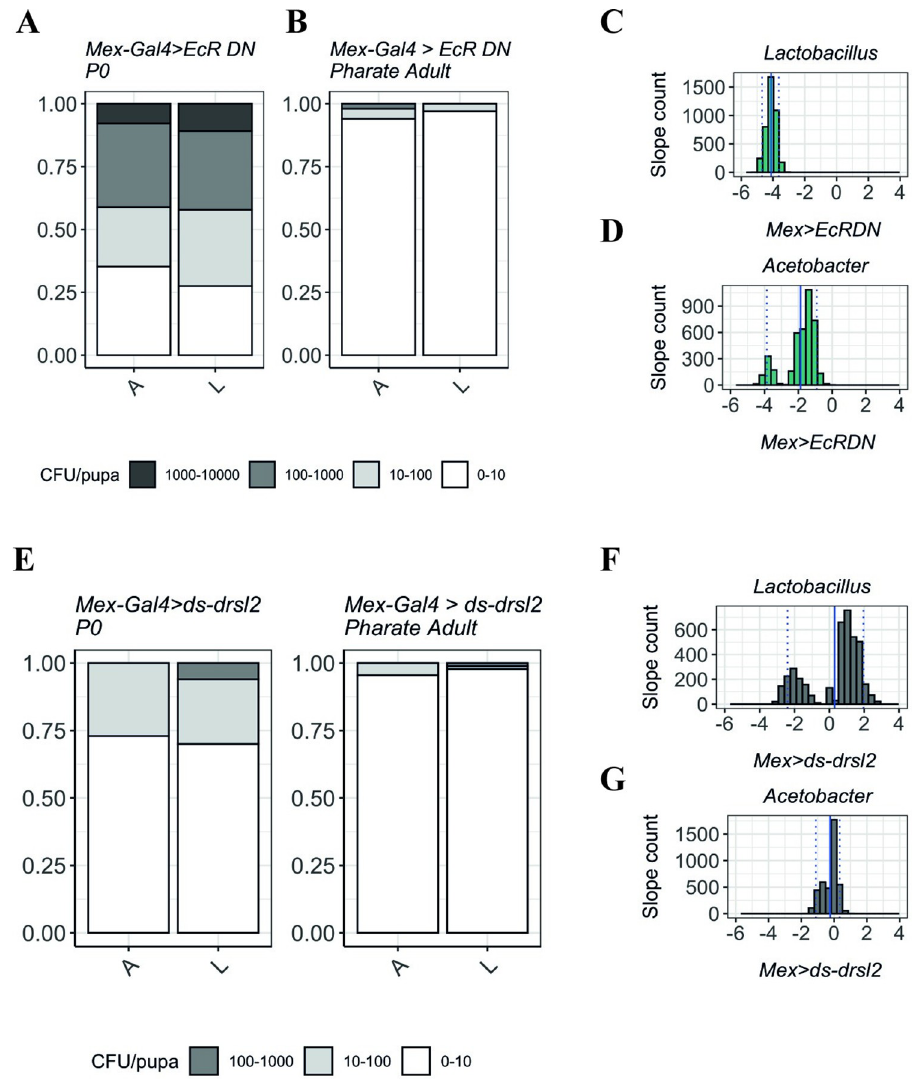
Fig 8. The role of local gut response in controlling the loads of Lactobacillus (L) and Acetobacter (A) in P0 pupae and pharate adults. (A-B) When ecdysone signalling is decreased in the enterocytes, the number of bacteria persisting metamorphosis does not increase. Y-axis represents the proportion of individuals in each bacterial count category. (C-D) Decrease in bacteria numbers in Mex > EcRDN individuals is reflected by negative coefficient values for both Lactobacillus (C) ( Median : -4 . 091 (IQR : -4 . 303; -4 . 108); One-way Wilcoxon test for median < 0 : < 2 . 2e-16 , r = 0 . 866 ) and Acetobacter (D) ( Median : -1 . 5413 (IQR : -2 . 0930; -1 . 2336); One-way Wilcoxon test for median < 0 : < 2 . 2e-16 , r = 0 . 866) . Doted lines represent the 0.05 and 0.95 quantiles; full line represents the mean slope. (E-F) Upon induction of RNAi against drsl2 in the midgut ( Mex > ds-drsl2 ), we observe a clearance of bacteria between P0 and pharate adult stages indicating a negligible role for drsl2 in the process. (G-H) Mex > ds-drsl2 samples coefficient not significantly different from 0 (same number of bacteria between P0 and pharate) for Lactobacillus ( Median : 0 . 9044 (IQR : -1 . 2893; 1 . 3397); One-way Wilcoxon test for median = 0 : < 1 . 239e-15 , r = 0 . 126 ) and Acetobacter ( Median : -0 . 09671 (IQR : -0 . 64948; -0 . 07480); One-way Wilcoxon test for median < 0 : < 2 . 2e-16 , r = 0 . 399